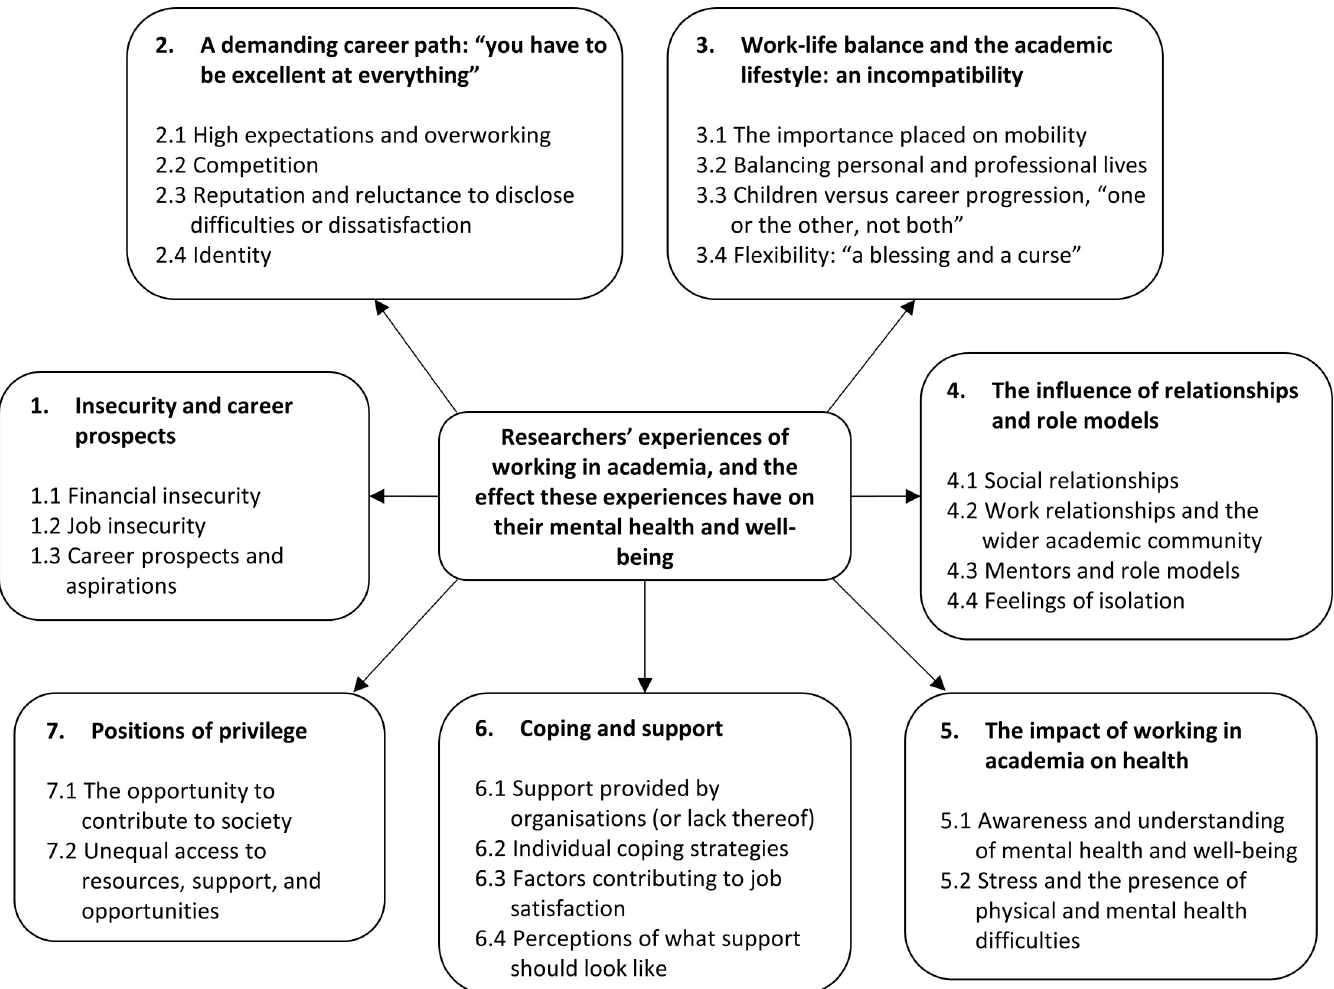
Fig 2. A visual representation of the main themes and sub-themes identified through the meta-synthesis.